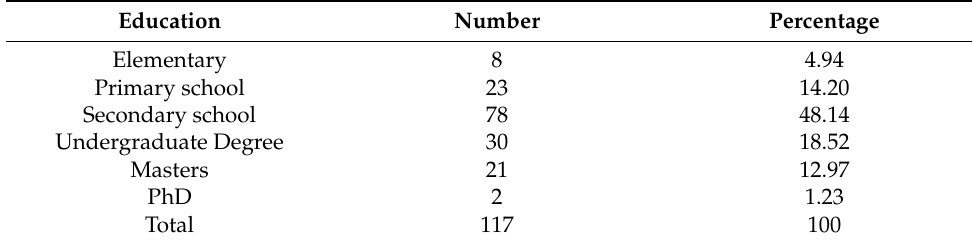
Table 2. Education level of the participants.